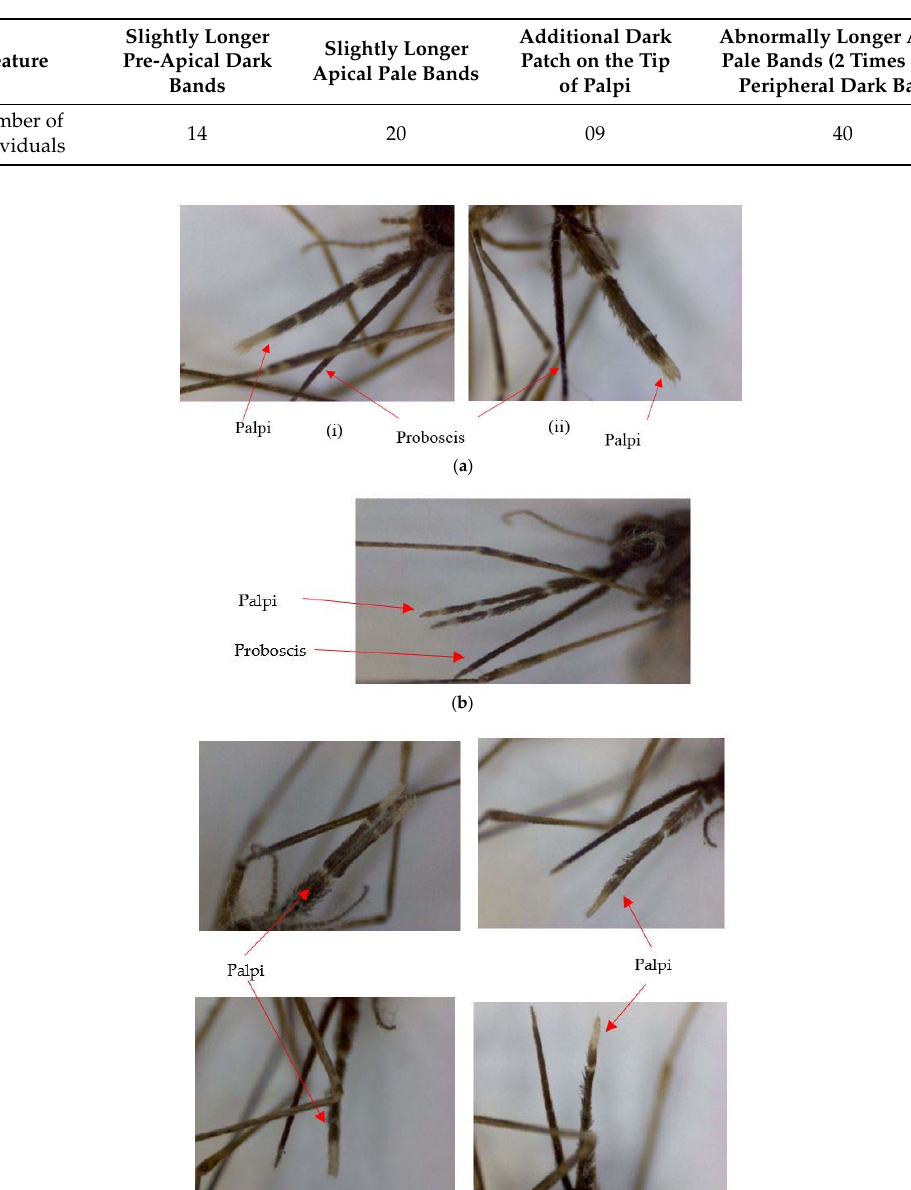
Table 3. Additional palp variations of adults.